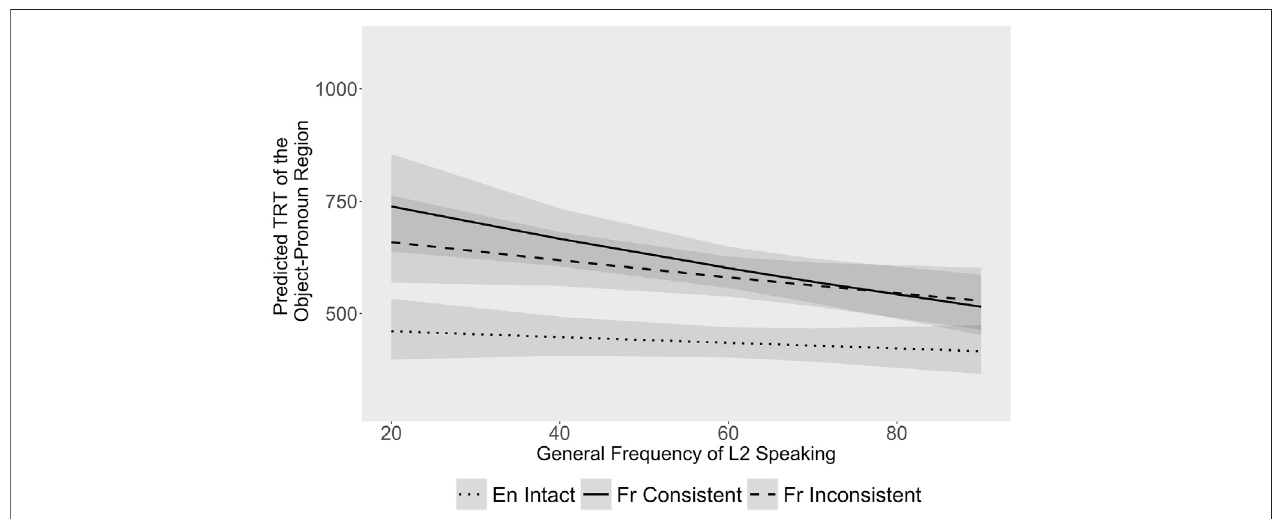
FIGURE 3 | Experiment 1 (French-English bilinguals reading in L2), interaction effect of general frequency of L2 speaking (out of 100%) on predicted total reading time (in ms) of the object-pronoun region. Shaded area represents plus/minus one standard error of the mean.